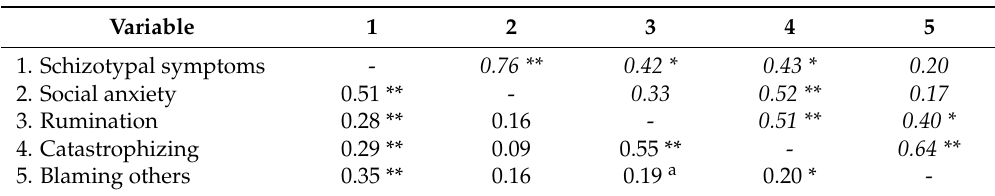
Table 2. Pearson Correlations between Schizotypal Symptoms, Social Anxiety Symptoms, and Cognitive Coping